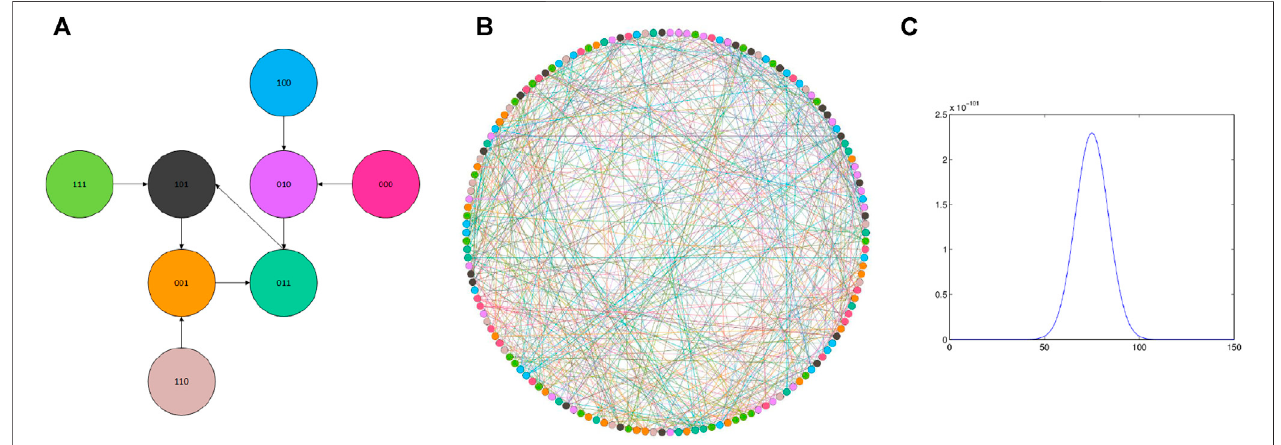
FIGURE 5 | Cells of the system ( 33 ) . State change in the system (33), and the distribution of these states of combination: (A) node ’ s state change, and there are eightstates inthese cells; (B) relation of150cells, and these cells wererandomly generated; (C) result ofthesystem(33): thedistributionofthesestates ofcombination.